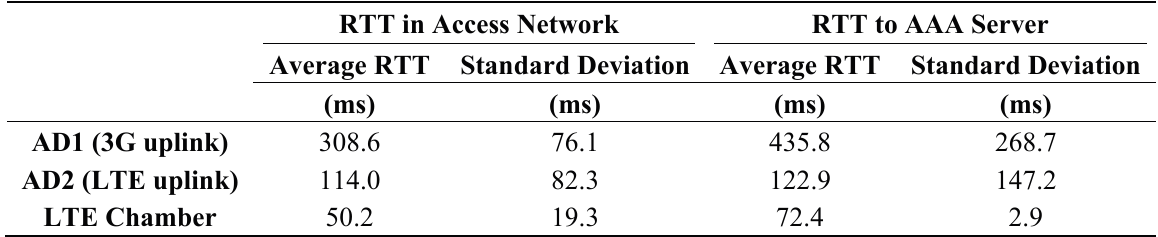
Figure 10. ( a ) Actual measured authentication delay in experiments 3 and 4 in AD1, AD2 and in the controlled radio environment; ( b ) Measured authentication delay as shown in ( a ) with compensation for internet backhaul latency. Table 2. Round-trip times from the gateway to the access network internet gateway and the AAA_H server respectively, measured at selected sensor locations used in the experiment presented in Section